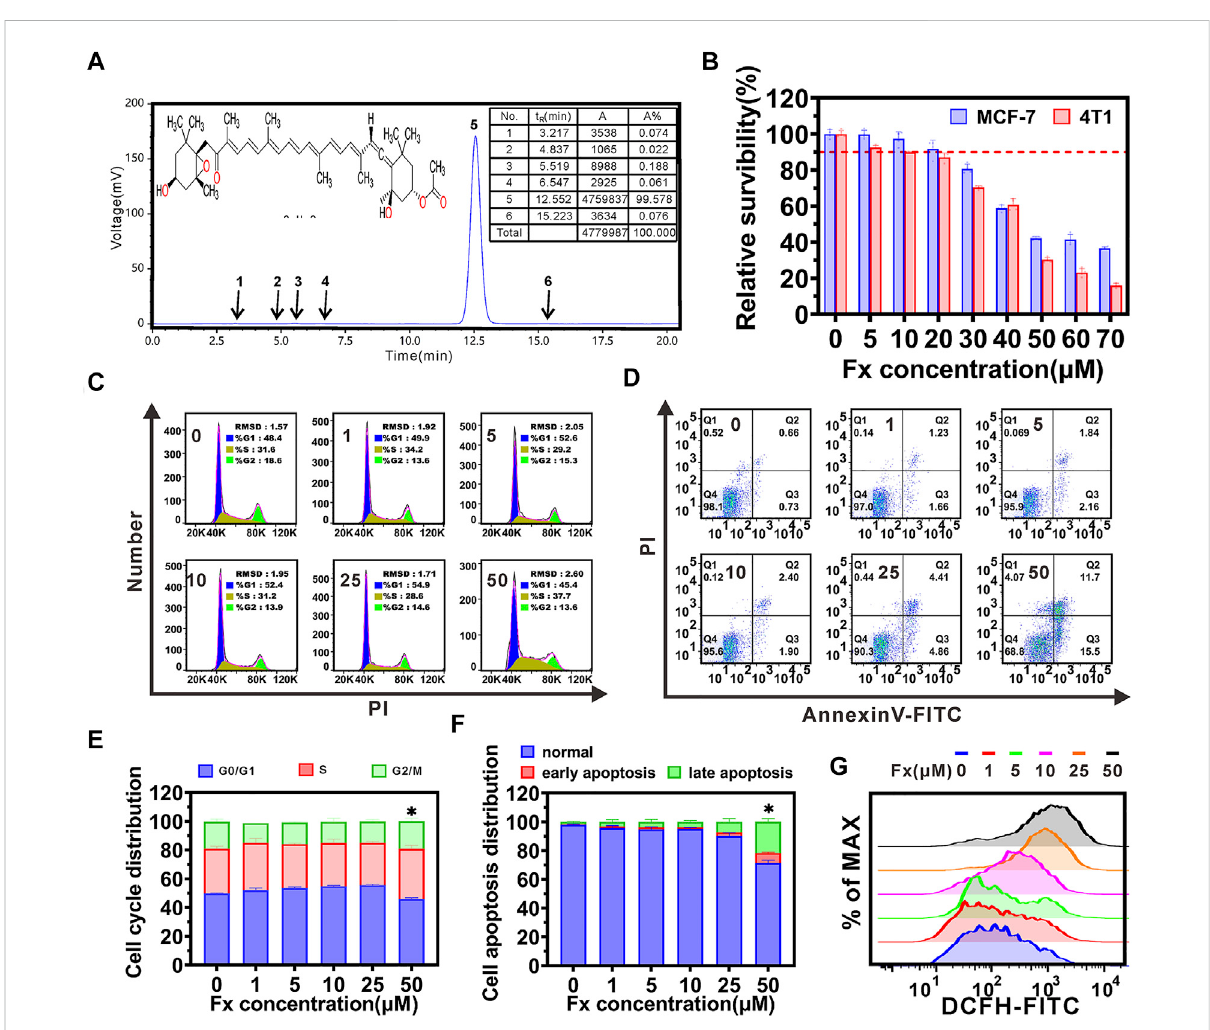
FIGURE 1 Inhibitory effects of Fucoxanthin (Fx). (A) Chemical structure and HPLC chromatogram of Fx. Peak at 12.5 min (peak 5) integration of the HPLC chromatogram indicated that the Fx is more than 99% purity. (B) The cytotoxicity of Fx to MCF-7 and 4T1 cells were determined by CCK8 assay,